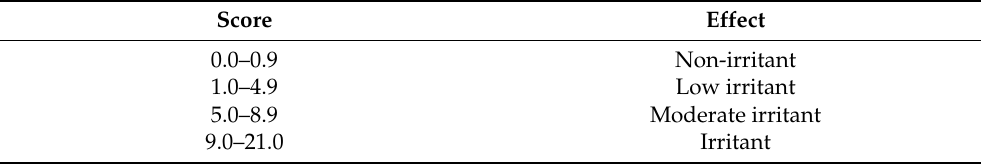
Table 1. Scoring Scheme for Irritation Testing.